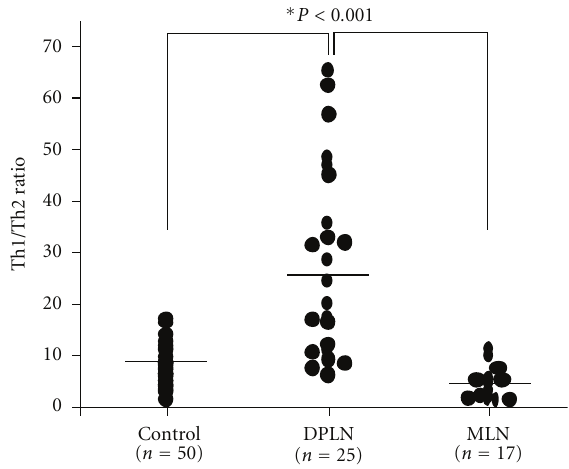
Figure 3: Distribution of the individual values of Th1/Th2 ratios in three groups control, DPLN, and MLN patients. Individual values of the ratio are plotted with the mean (bar) for each group, and ( n ) refers to the number of individuals in each group. The mean ± SD values were as follows. Healthy normal control 8.82 ± 4.45, DPLN 25.89 ± 18.98, and MLN 4.66 ± 4.64, respectively. The value of DPLN was significantly higher than those of normal and MLN. P values determined by Student’s t